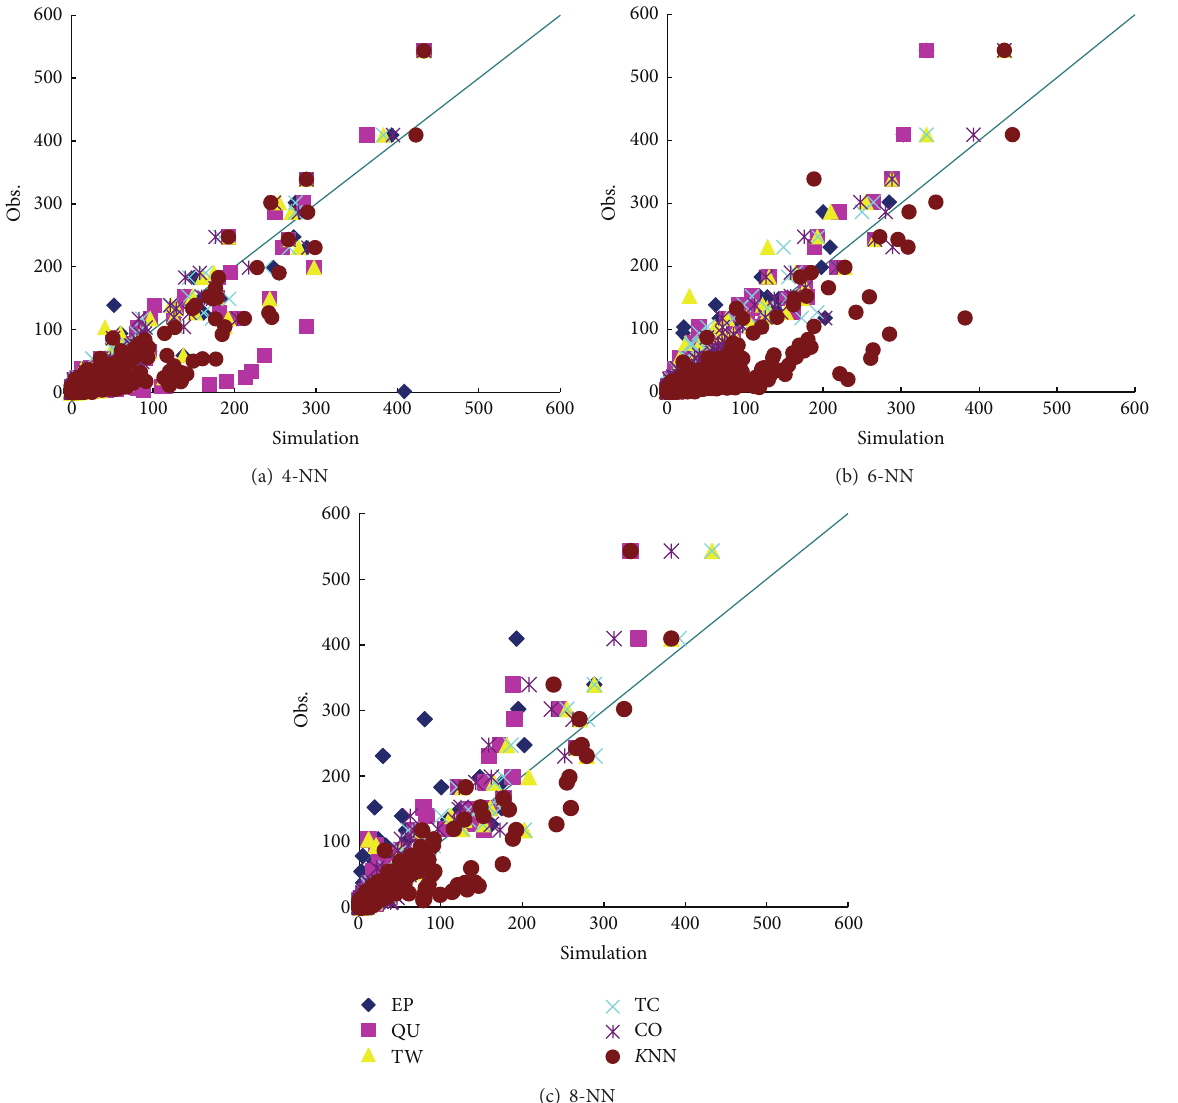
Figure 4: Scatter plots for SWAT simulation (EP, QU, TW, TC, CO, and 𝐾 NN represents Epanechnikov, Quartic, Triweight, Tricube, Cosine, and 𝐾 NN-regression,